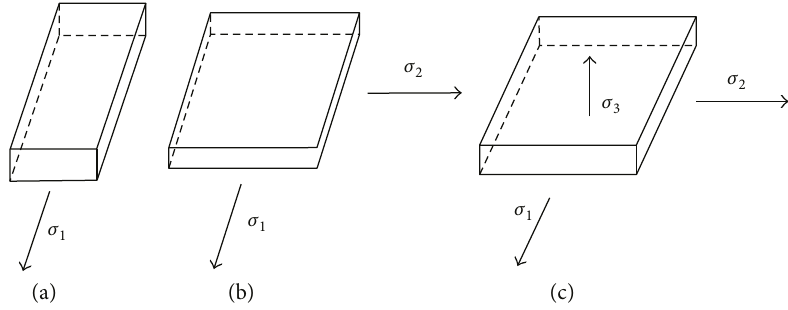
Figure 3: Analyses of the stress in di ff erent